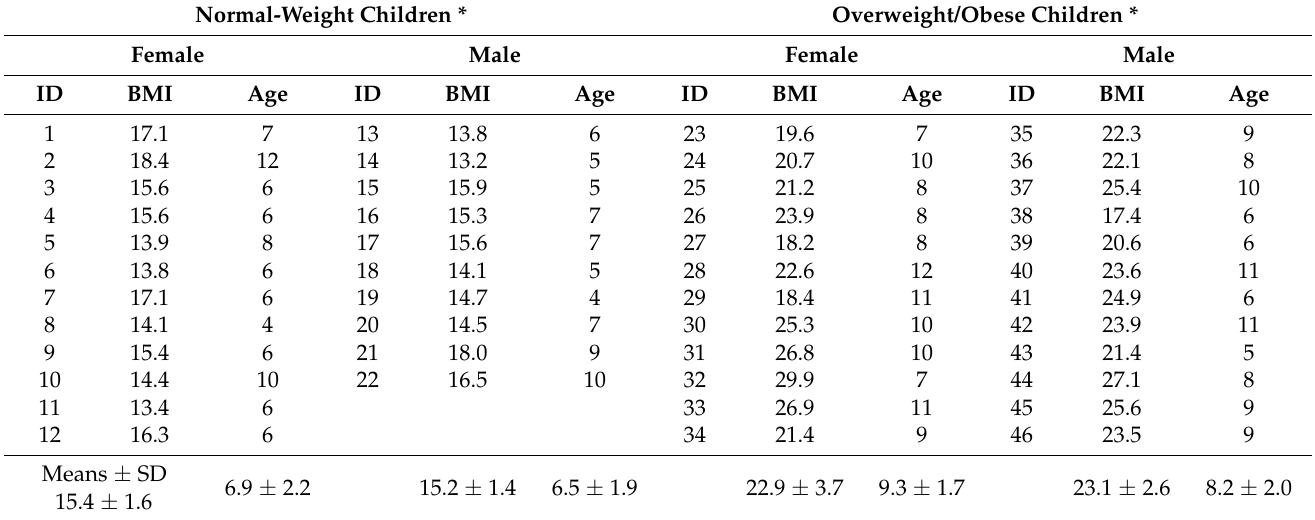
Table 2. Anthropometry global data from children with obesity and normal-weight individuals categorised by